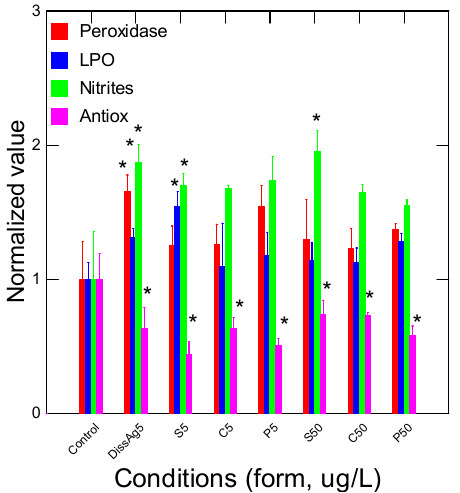
Figure 4. Oxidative stress and damage in trout exposed to nAg forms. Oxidative stress was deter- mined by following the changes in peroxidase, lipid peroxidation, nitrites (NO 2 ), and antioxidant (Antiox) potential in gills of rainbow trout exposed to Ag forms. The data represent the mean with standard error. The star * symbol indicates signi fi cance at p ≤ 0.05 relative to controls. Tissue damage in trout exposed to various forms of Ag was determined by following the levels of DNA breaks, protein aggregation, and heme degradation product bilirubin (Figure 5). Viscosity was also included although not strictly a marker of damage. DNA damage was present in all Ag forms where the genotoxic potential of dissolved Ag is sim- ilar to all forms of nAg. Correlation analysis of DNA damage revealed a signi fi cant trend with NO 2 levels (r = 0.68), peroxidase activity (r = 0.45), glucose (r = 0.87), and acetoacetate (r = 0.39). Protein aggregation was signi fi cantly reduced by cubic and spherical nAg for the low and high concentrations. A reduction in protein aggregation also occurred for spherical nAg but only at high concentrations. Correlation analysis revealed signi fi cant relationships with glucose (r = 0.36) and LPO (r = 0.46). The levels of Bil were determined as an indicator of heme damage. Bil levels were decreased in fi sh exposed to the lowest concentration of cubic nAg and at the highest concentration of prismatic nAg. Correlation analysis revealed that Bil levels were correlated with glucose (r = 0.62), antioxidant poten- tial (r = 0.67), and protein aggregation (r = 0.3). Viscosity changes tended to be lower by the forms of nAg but not signi fi cantly. However, a signi fi cant increase in viscosity was observed for the low concentration of spherical nAg. The correlation analysis of viscosity revealed a signi fi cant correlation with esterase activity (r = − 0.36), LPO (r = 0.72), protein aggregation (r = 0.63), and total lipids (r = 0.37). In an a tt empt to gain a global view of the various responses, a principal component analysis was performed (Figure 6). The total variance was 50% and the following biomarkers had the highest component weight (>0.7): viscosity, glucose, DNA proteins, NO 2 levels, and gill protein levels. Changes in viscosity were closely associated with protein aggregation and LPO. DNA damage and NO 2 levels were closely related with each other, peroxidase activity, and bilirubin, suggesting the involvement of oxidative stress and increased hemoprotein turnover. Gill Ag levels were closely related with acetoacetate and esterase activity, suggesting impacts on gluconeo- genesis and lipid mobilization.